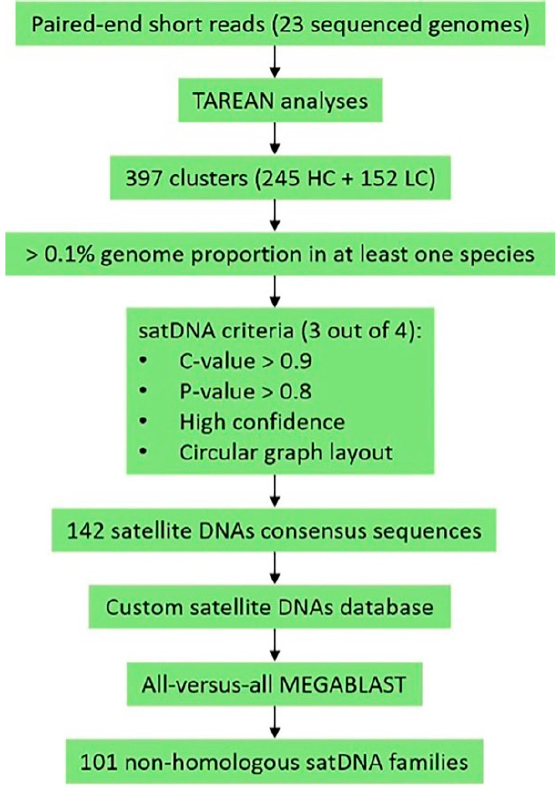
Figure 2. Workflow used for satellite DNA (satDNA) identification in the 23 sequenced montium genomes.